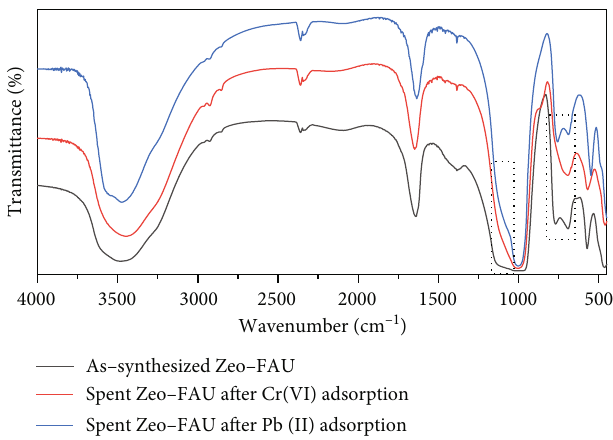
Figure 2: FT-IR spectra of synthesized RHA-based zeolite FAU before and after adsorption of Pb(II) and Cr(VI) ions.